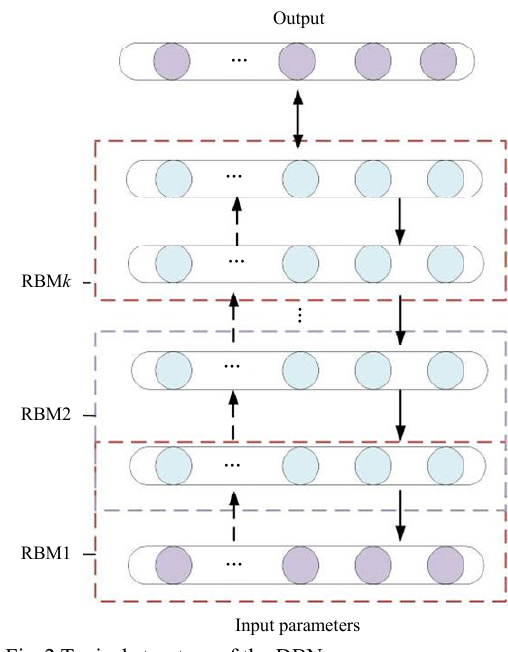
Fig. 2 Typical structure of the DBN.